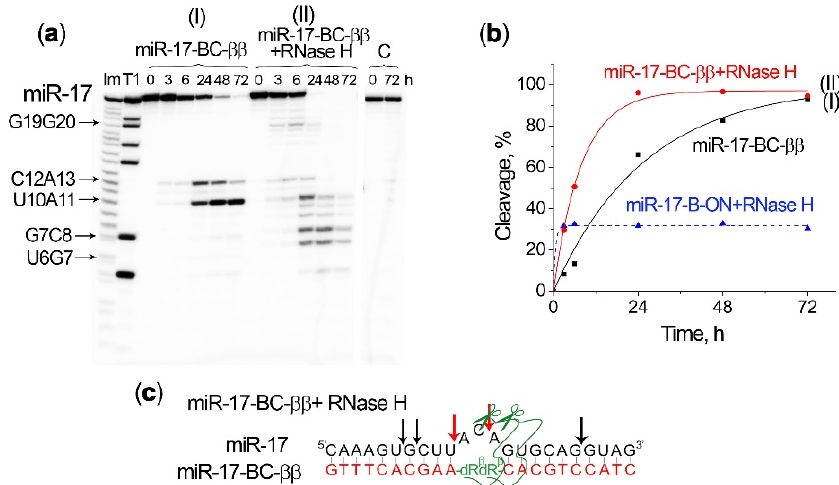
Figure 6. Cleavage of 5 (cid:48) -[ 32 P]-miR-17 by miR-17–BC- ββ and/or RNase H. ( a ) Radioautographs of 18% denaturing PAAG showing the profiles of miR-17 cleavage by miR-17–BC- ββ alone (I) and by a combination of miR-17–BC- ββ and RNase H (II). Duplexes formed by 5 (cid:48) -[ 32 P]-miRNA (1 µ M) and BC (20 µ M) were incubated in Buffer 2 at 37 ◦ C for 72 h. RNase H was used at a concentration of 5 u/mL. Lanes Im and T1: imidazole ladder and partial RNA digestion with RNase T1, respectively; C: control, RNA was incubated in the same buffer in the absence of BC and in the presence of RNase H. The incubation time is shown at the top. ( b ) Progress curves of miR-17 cleavage by miR-17–BC- ββ and/or RNase H. For a comparison, the dashed curve shows the cleavage of miR-17 by RNase H in a complex with the oligonucleotide B-ON. ( c ) The major positions of miR-17 cleavage by a combination of miR-17–BC- ββ (red arrows) and RNase H (black arrows).